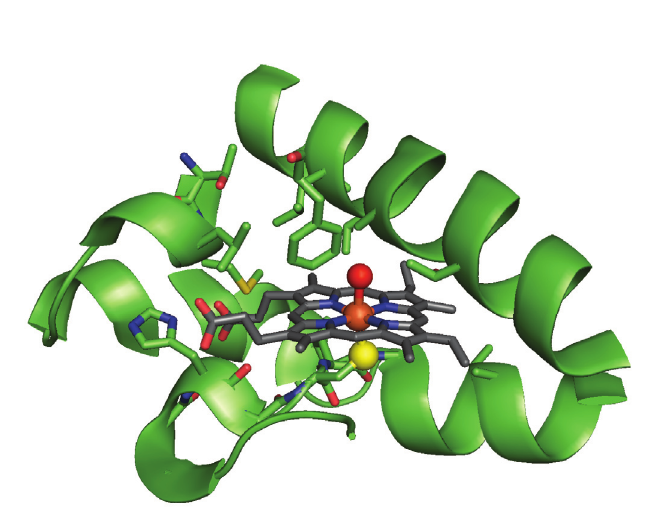
Figure 3. Typical active site of cytochrome P450 and aromatic peroxygenase heme-thiolate